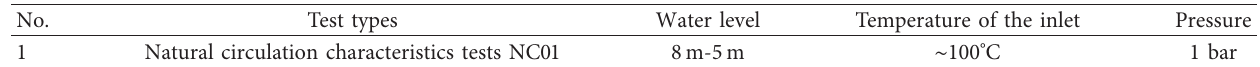
Table 4: Test conditions for the natural circulation